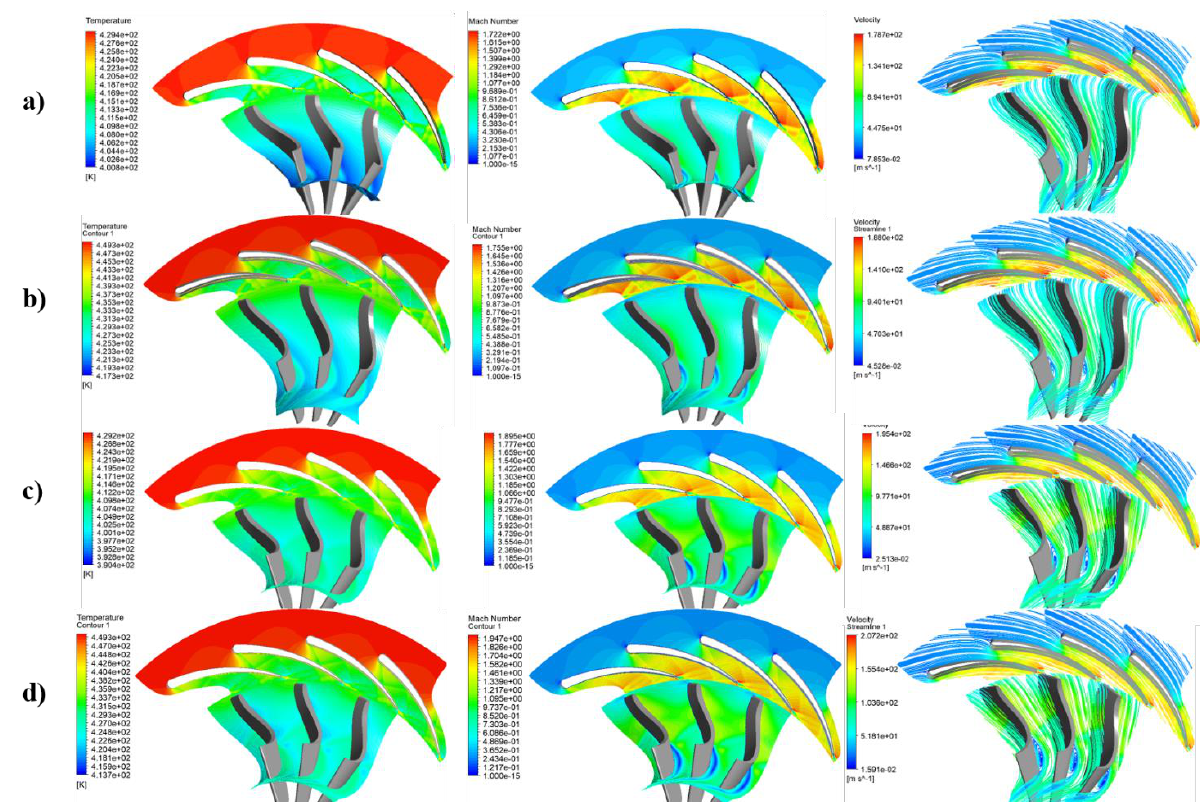
Figure 24. Temperature distributions, Mach numbers, and velocity streamlines at 50% span for ( a ) T = 430 K, N = 40,000 rpm, ( b ) T = 450 K, N = 40,000 and ( c ) T = 430 K, N = 30,000 ( d ) T = 450 K, N = 30,000 rpm.